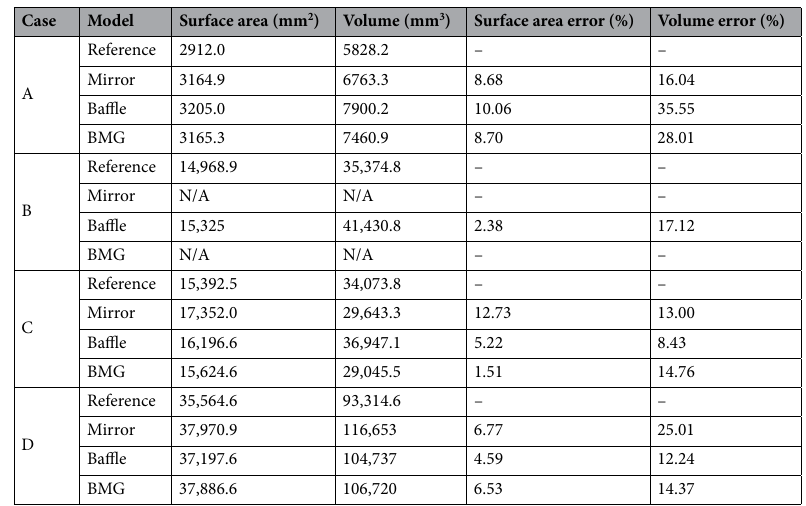
Table 2. Comparison of surface and volume of the mirrored, baffle, BMG, and the reference models. Surface area and volume errors of the designed models are computed against the reference models. N/A means that the model is unable to be mirrored.